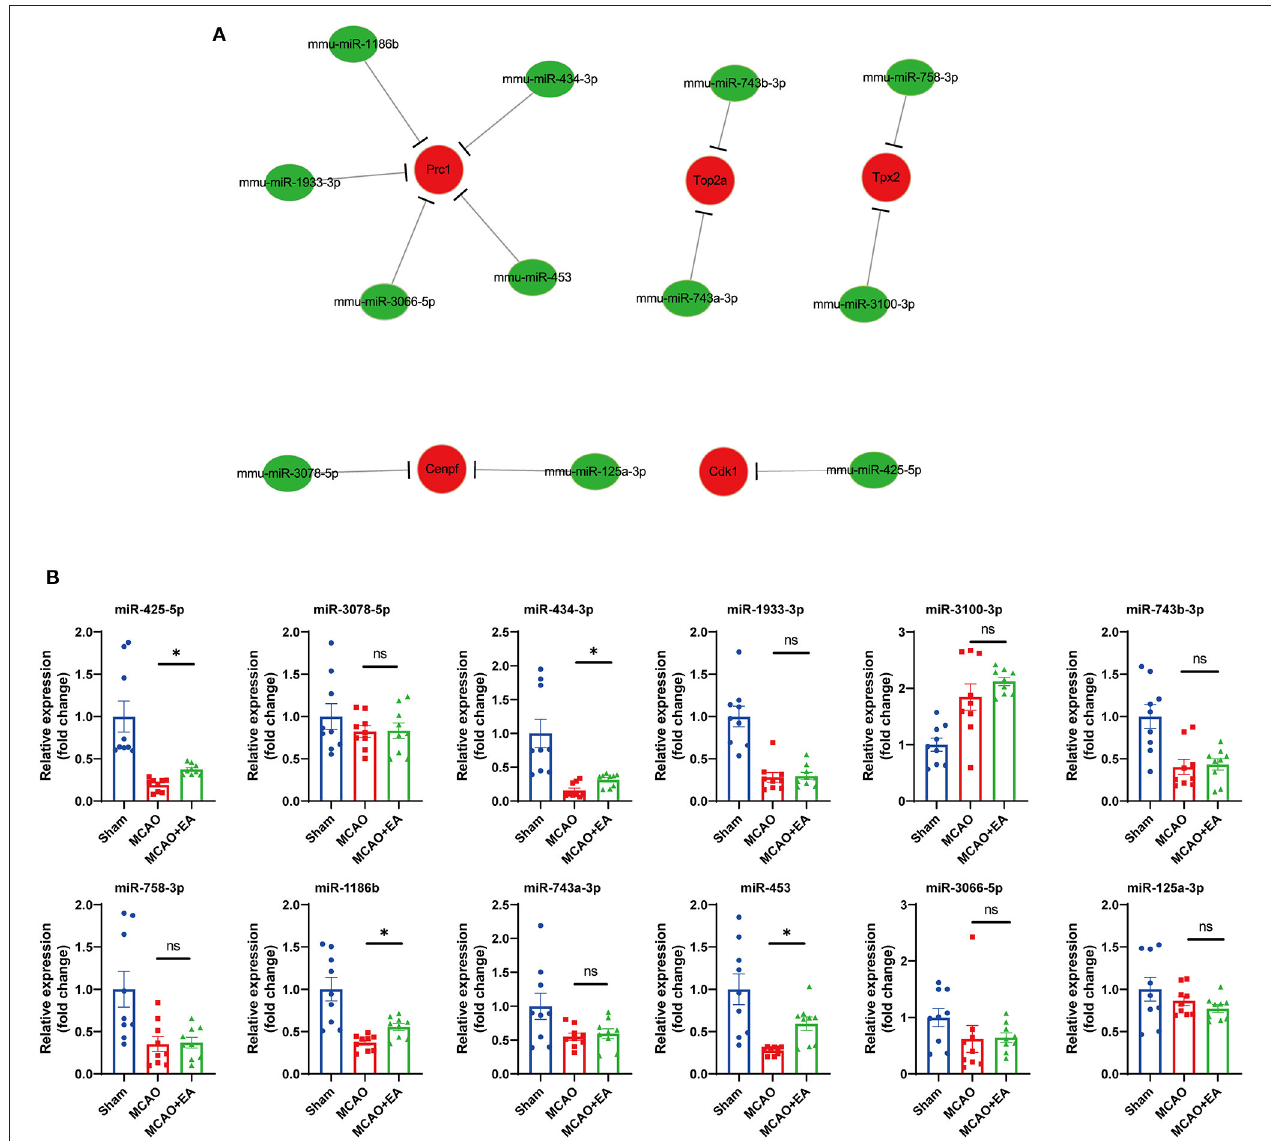
FIGURE 7 | Prediction and validation of upstream miRNAs of hub genes. (A) Construction of miRNA-gene network using Cytoscape. (B) Validation of 12 predicted miRNA with RT-qPCR. Statistical graph shows fold change of miRNA expression regulated by EA treatment, normalized to U6 level. Data are represented as means ± SEM, n = 3 mice/group (with three technical replicates). One-way ANOVA followed by Bonferroni (if equal variances assumed) or Dunnett’s T3 (if equal variances not assumed) post-hoc test was used for statistical analysis. * p < 0.05, ns p >